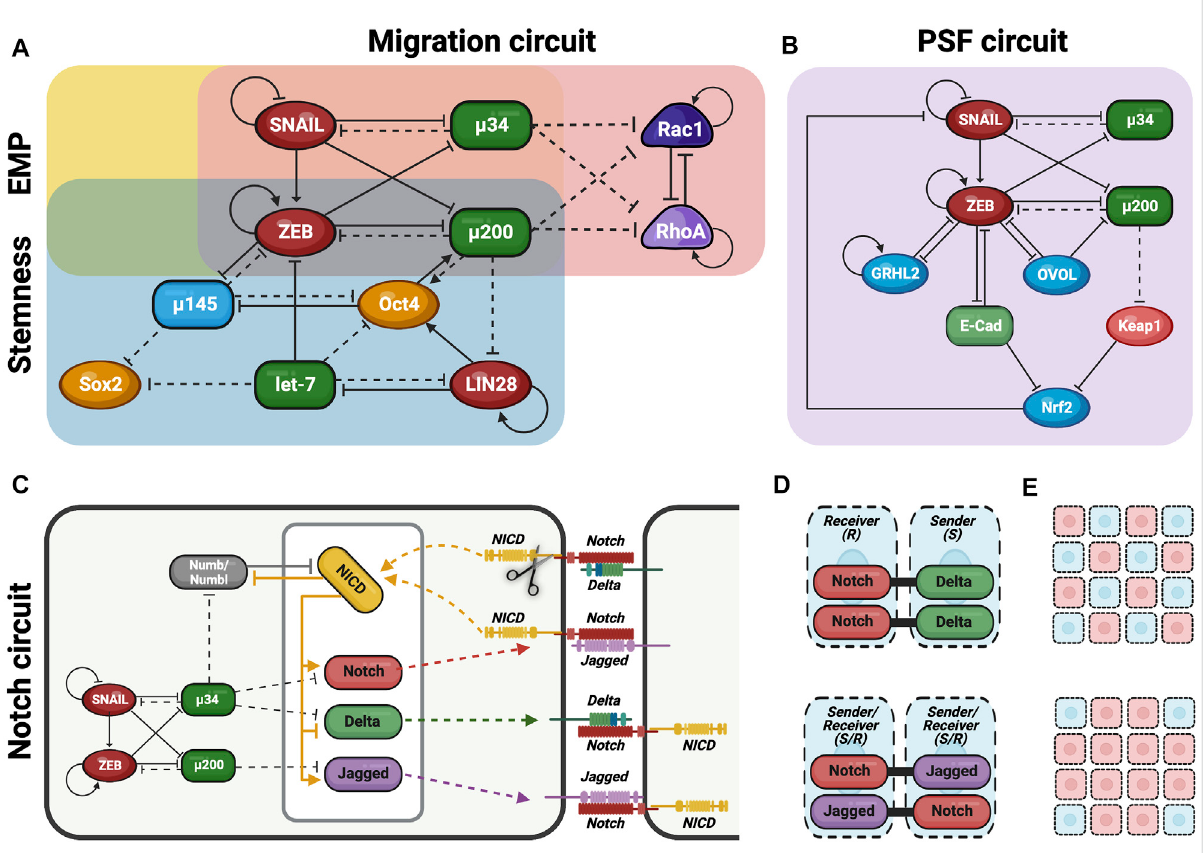
FIGURE 2 Gene regulatory networks (GRN) govern the fate of hybrid E/M cells. Schematic overview of the different GNR involved in the modulation of hybrid E/M phenotype decisions. (A) EMP circuit (yellow) is formed by the interaction of two mutually inhibitory feedback loops (miR-200/ZEB and miR-34/SNAIL) and regulates EMT/MET decisions. Stemness circuit (blue) integrate EMP circuit with another mutually inhibitory feedback loop formed by LIN28/let-7 and regulates the expression of stemness genes. Migration circuit (red) involves Rac1/RhoA interactions and is also integrated with EMP circuit thus regulating the switch between collective and individual migration. (B) Phenotypic Stability Factors (PSF) such as OVOL, GRHL2 and Nrf2 maintain the hybrid E/M phenotype, thus avoiding a complete EMT. PSF circuit (purple) is completely integrated in the EMP circuit and their interactions regulate the cell fate. (C) Coupling EMP circuit with Notch circuit (light green) which regulates cell-cell communication and cell asymmetry. (D) Notch-Delta signaling induce different fate in neighboring cells: one becomes Sender (high Delta/low Notch) and the other becomes Receiver (high Notch/low Delta). This behavior causes lateral inhibition and promotes the formation of the so-called “ salt and pepper ” pattern.Notch-JaggedsignalinginducesthesamefateinneighboringcellswhichbecomeSender/Receiver(highNotch/highJagged).Thisbehavior causes lateral induction and promotes the formation of the similar pattern among neighboring cells. (E) Therefore, during lateral inhibition (up) cells in partial EMT might not be spatially close, thus promoting single cell asymmetry. Conversely, during lateral induction (down) cells in partial EMT can mutually stabilize the hybrid E/M phenotype, thus generating cluster symmetry (Figures 2C – E have been adjusted from Bocci et al.,